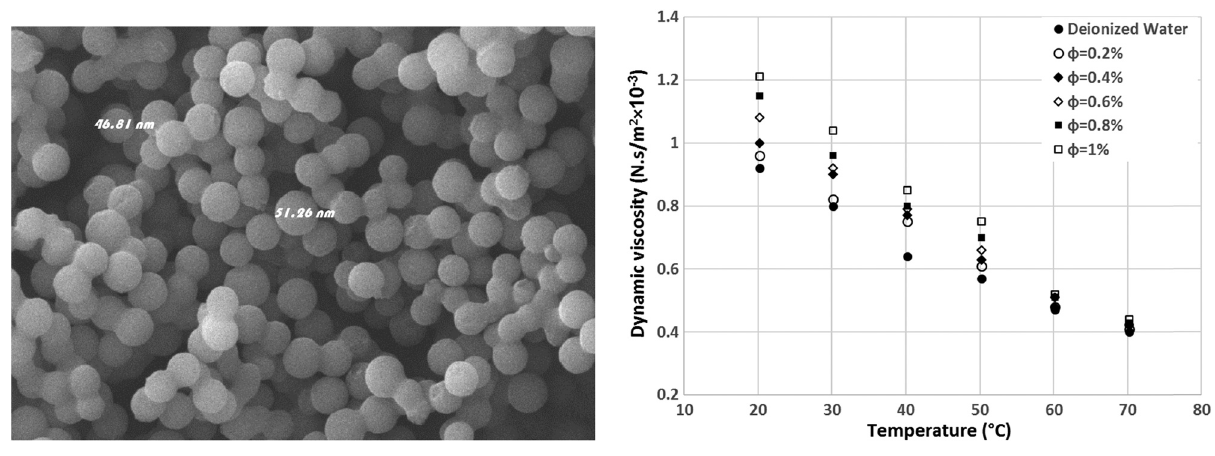
Figure 1: SEM of CuO – Cu nano fl uid suspension.